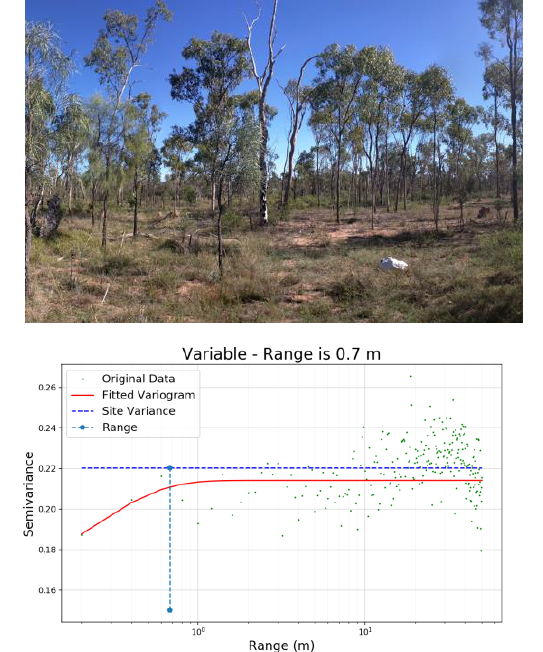
Figure 4. Typical Variable and SOI stocking rate sites. Wamble 3 is variable stocking and range is 0.7